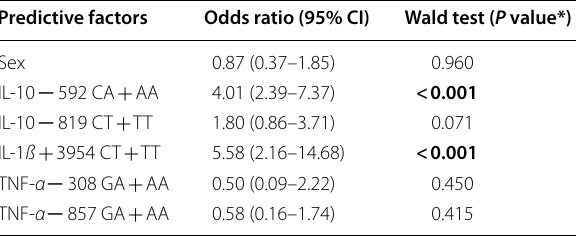
95% CI 95% Confidence Interval = *Statistically significant values are presented in bold